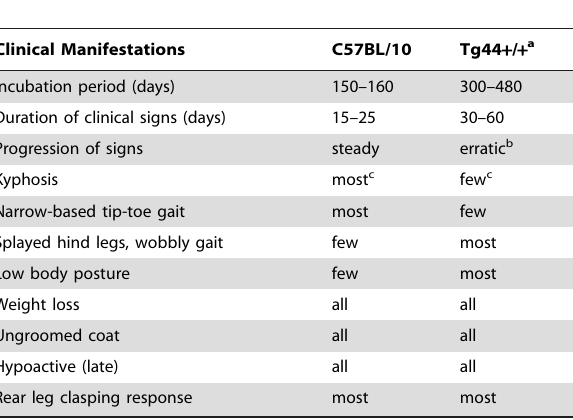
Table 1. Clinical aspects of disease in 22L or RML scrapie- infected C57BL/10 and tg44 + / +